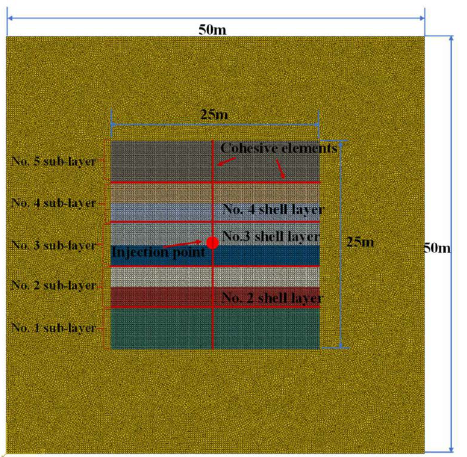
Figure 4. Finite element model of fracture crossing layers and mesh